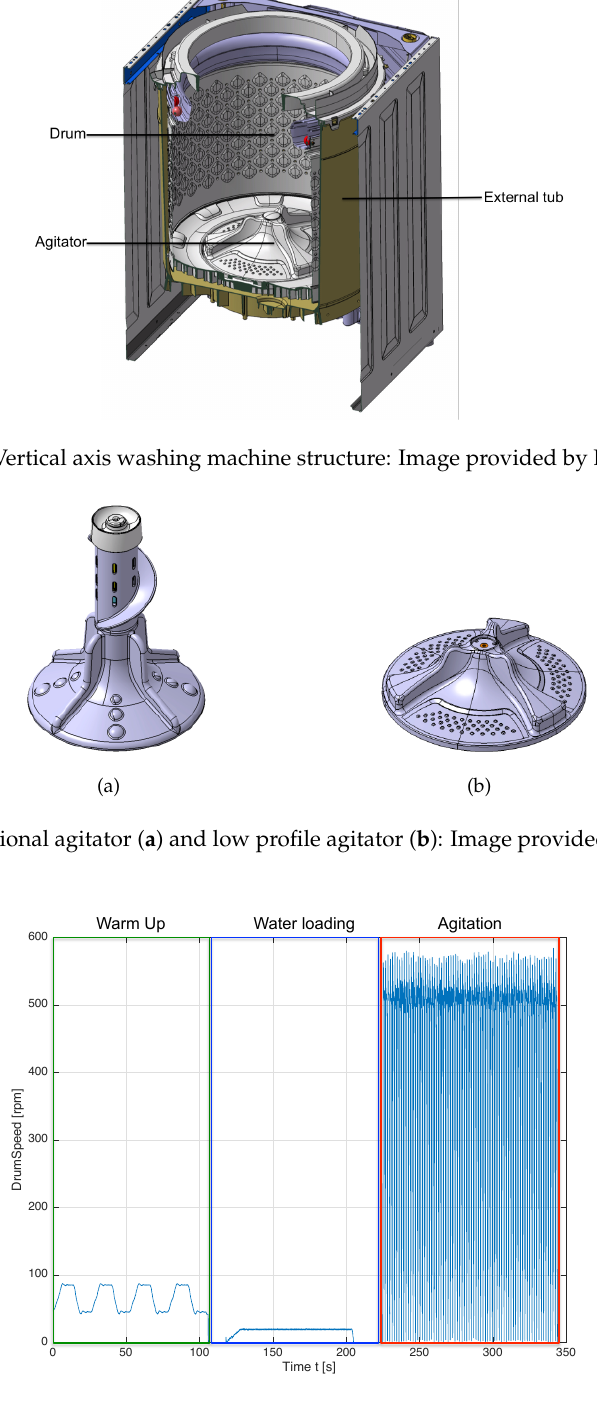
Figure 5. Time evolution of the drum speed during a single